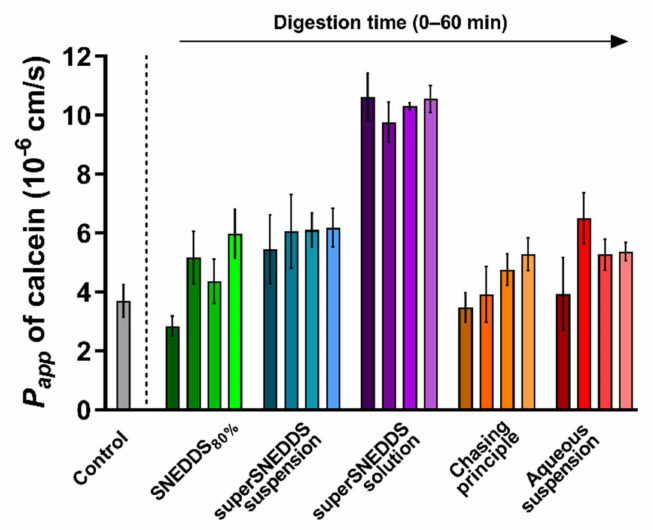
Figure 3. PermeaPad ® stability depicted as calcein P app values calculated from the 3 h of exposure to the different formulations before (0 min lipolysis time, darkest shade of every color) and after digestive enzyme addition (15, 30, and 60 min of lipolysis, the lightest shade of each color represents 60 min of lipolysis). The calcein P app from the control experiments (grey bar) with no formulation or digestion is depicted for comparison. All data are depicted as the mean ± SEM ( n =